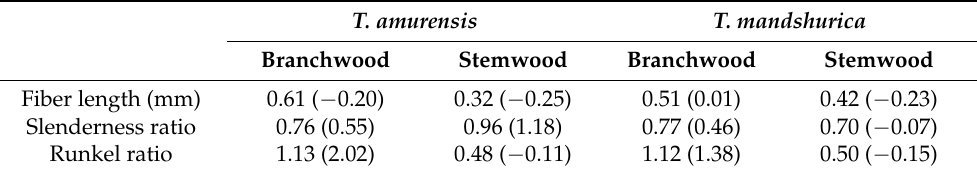
Table 4. Skewness and kurtosis (data in brackets) of normal distribution curves for fiber length, slenderness ratio and Runkel ratio.